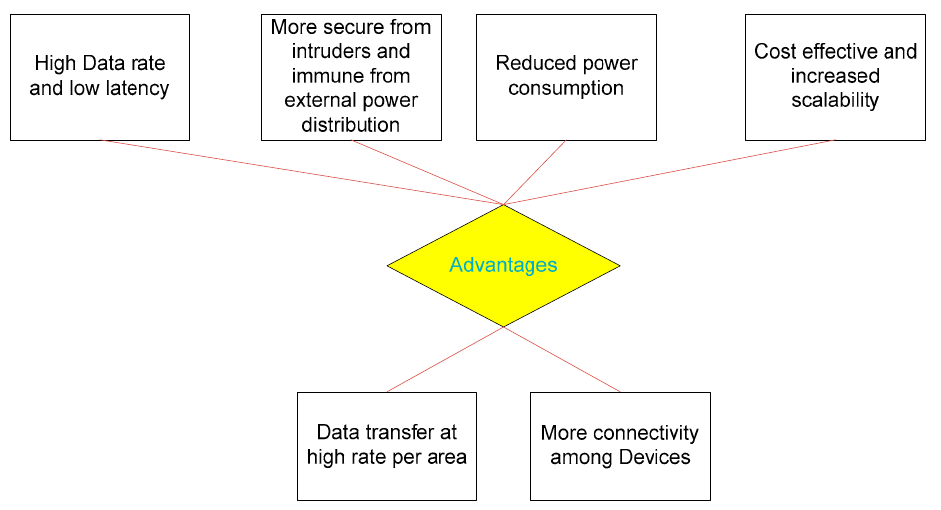
Figure 5. Benefits of 5G networks in smart grids.